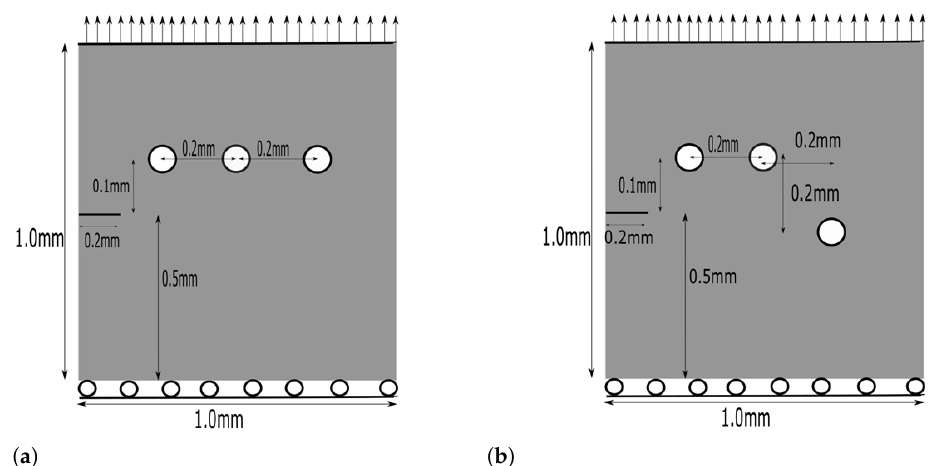
Figure 9. Geometry with notch and openings (in x - y plane): ( a ) openings are aligned along a straight-line; and ( b ) openings are aligned haphazardly.